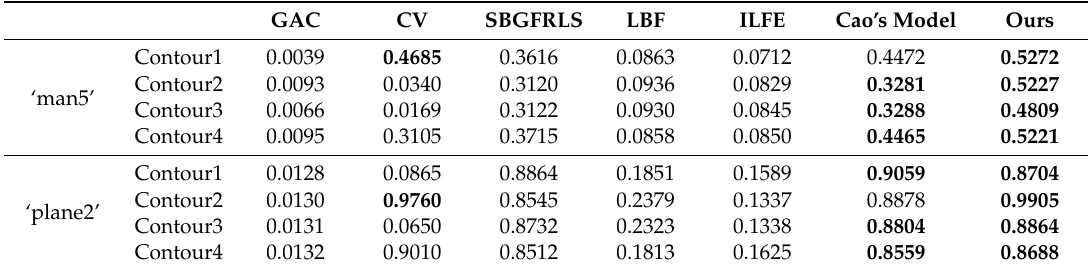
Table 7. Statistic of BP values (‘man’ and ‘plane’ image), and bold values indicate the top two